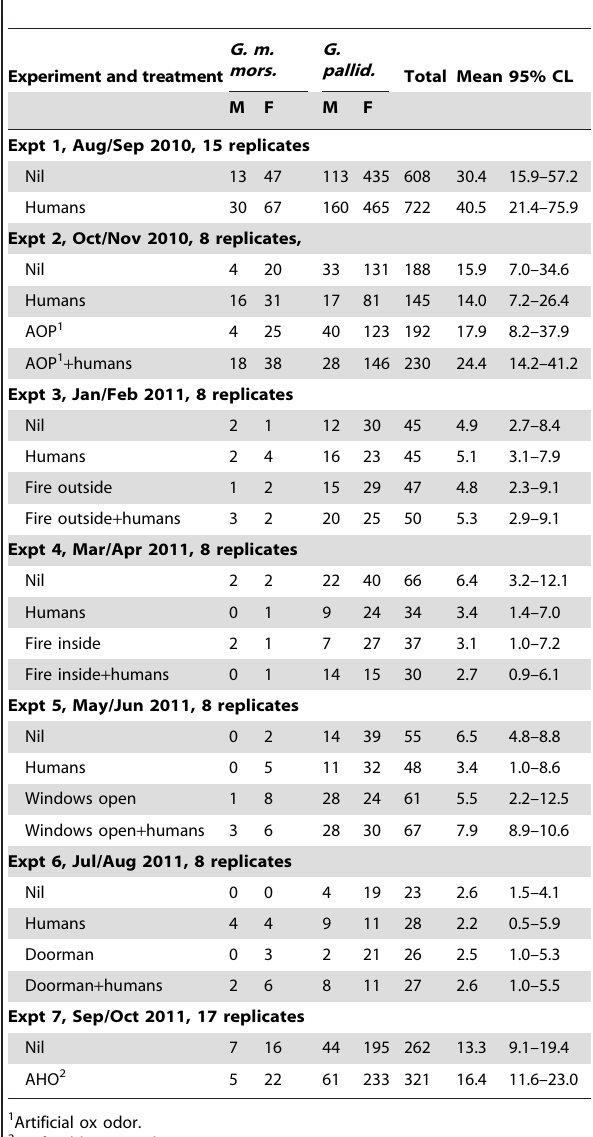
Table 1. Catches of tsetse from the house, in seven separate experiments with various treatments.